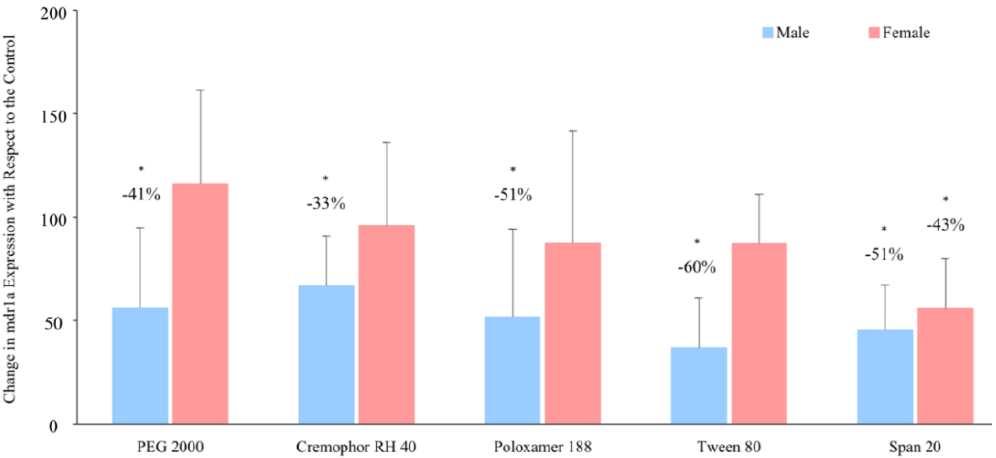
Figure 6. Percentage changes in mdr1a mRNA expression in the presence of excipients in male and female Wistar rats (mean ± SD, n = 6). * Values are statistically di ff erent between the control (i.e., no excipient) and the excipient groups at p < 0.05.